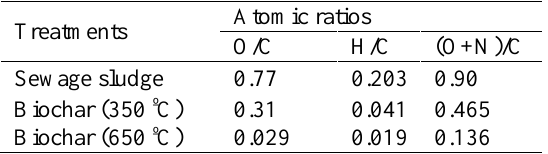
Table 3. Effect of pyrolysis temperature on the atomic ratios of biochar Atomic ratios Treatments